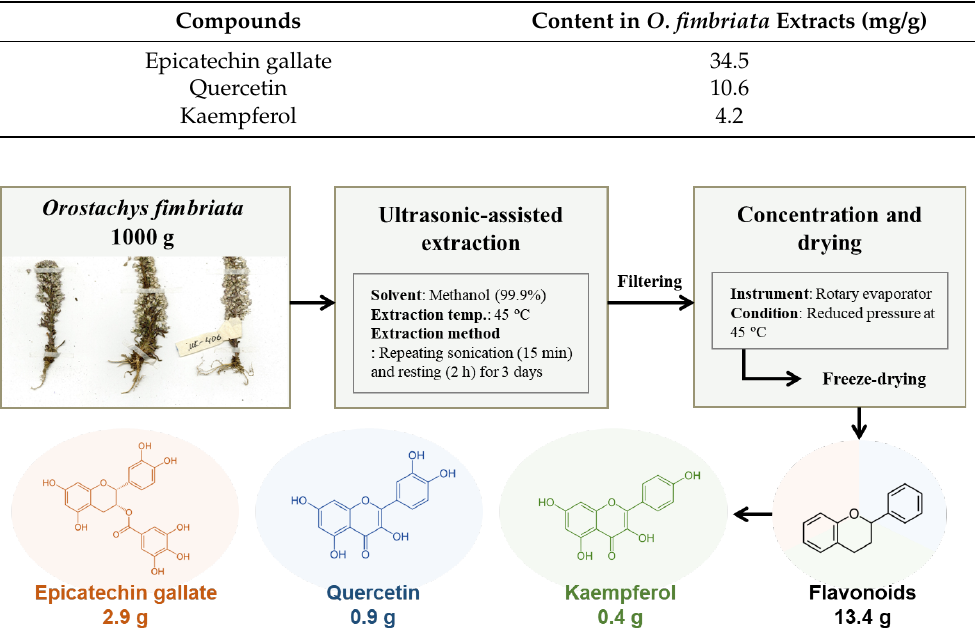
Figure 4. Mass spectra for identification of epicatechin gallate ( a ), quercetin ( b ), and kaempferol ( c ) in O. fimbriata extracts. Table 3. Quantification of epicatechin gallate, quercetin, and kaempferol in Orostachys fimbriata extracts.